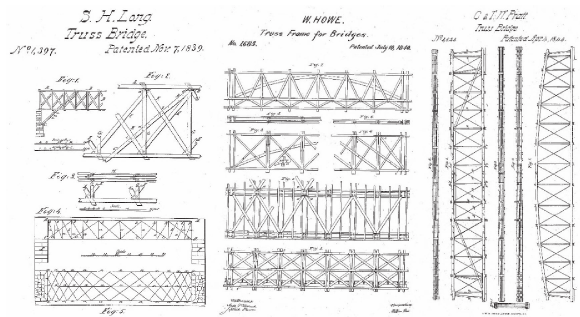
Figure 3: Left: S. H. Long Patent [14]; Center: W. Howe Patents [22, 23]. Right: C & T. W. Pratt Patent